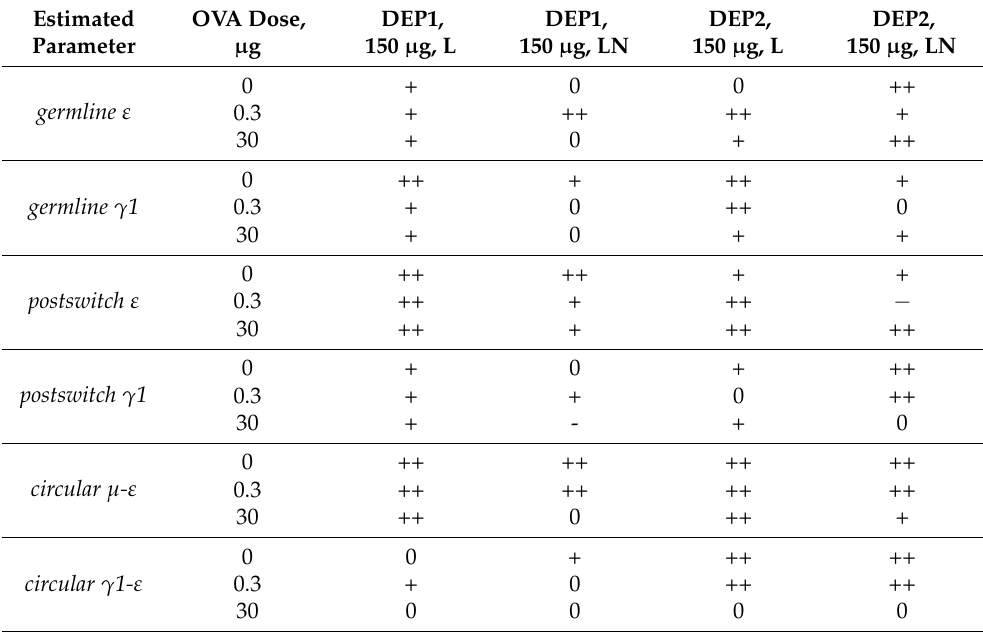
Table 2. The effect of DEPs on the expression of transcripts of markers of antibody class switching and antibody production in the lung tissue and regional lymph nodes of immunized mice in comparison with mice immunized without DEPs with the indicated OVA